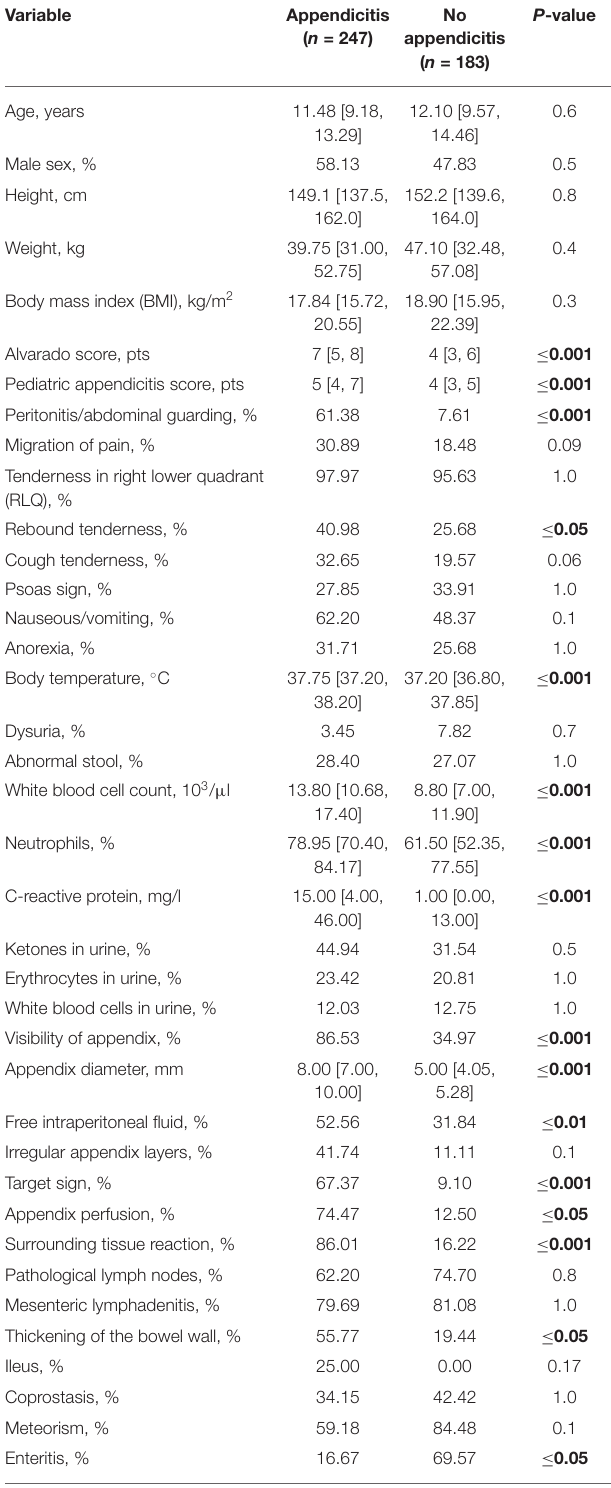
significantly outperformed logistic regression (average